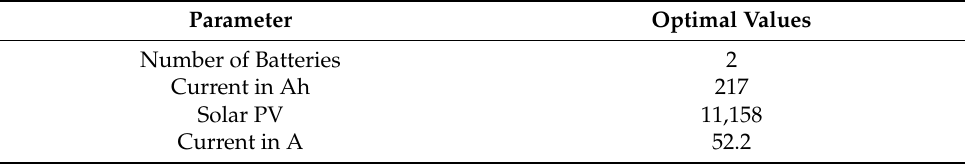
Table 2. Parameters for optimal sizing for PSO.